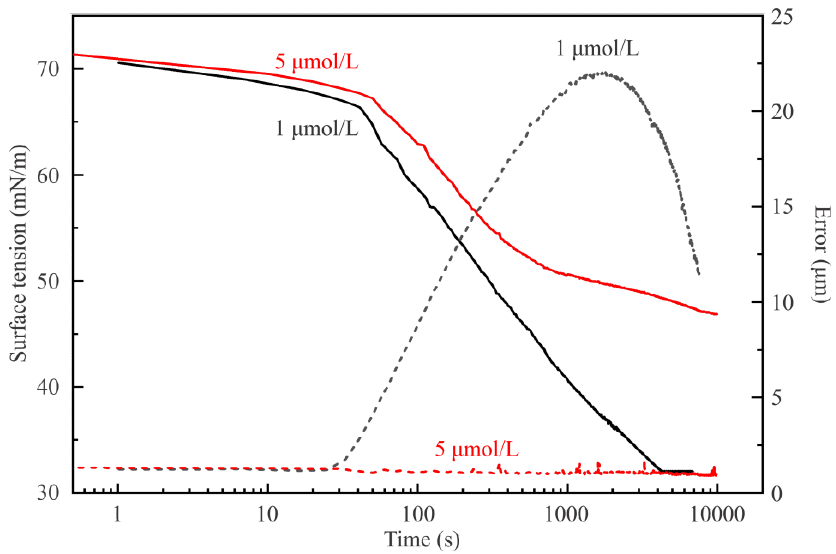
Figure 8. Dynamic surface tension and fitting error for aqueous solution drops of C 13 DMPO of concentrations of 1 µmol/L and 5 µmol/L in hexane vapor.